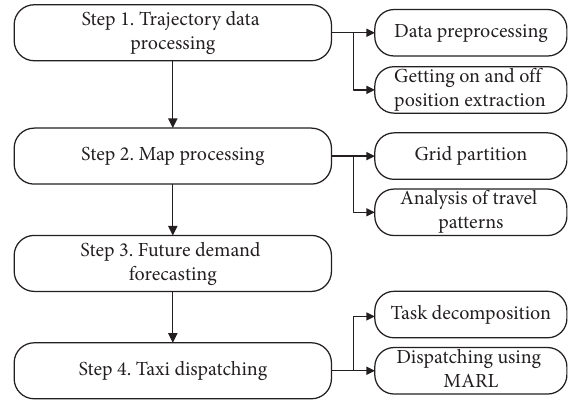
Figure 1: Processing